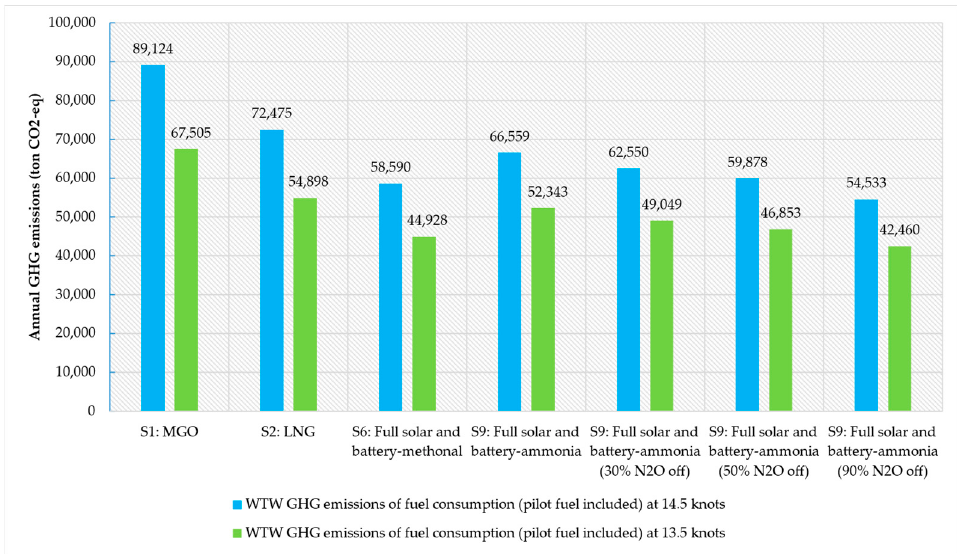
Figure 9. Comparison of annual WTW GHG emissions considering N 2 O abatements of using am- monia.